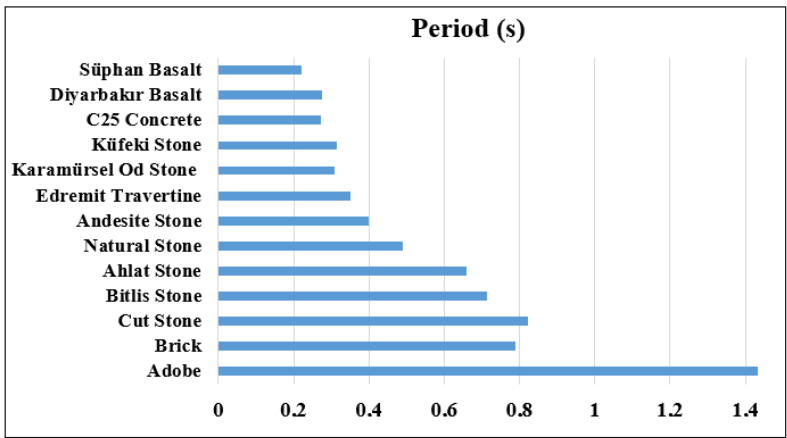
Figure 8. Comparison of the natural fundamental period of the 1st mode (H = 25.40 m).